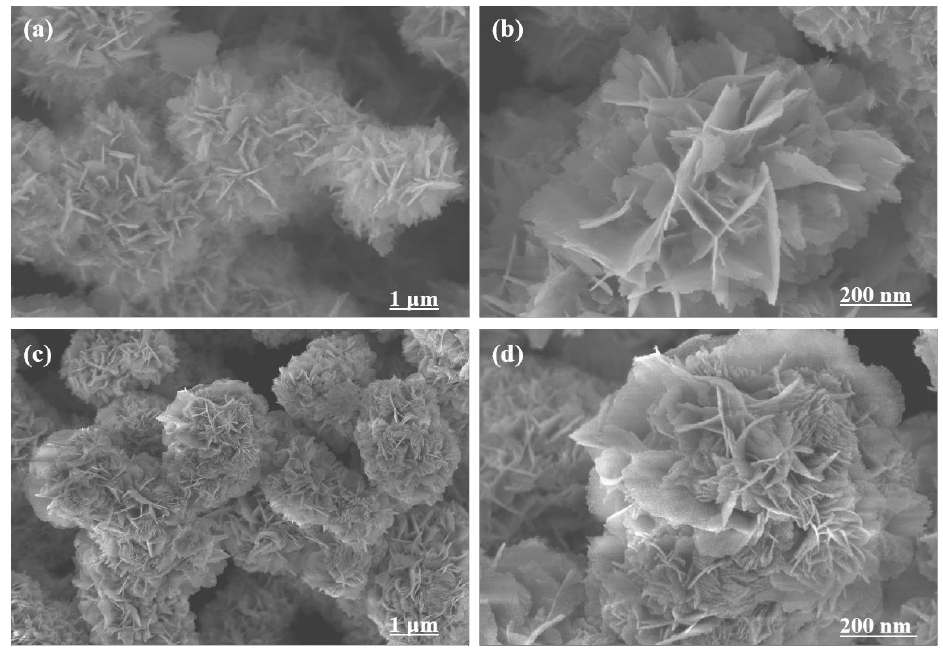
Figure 2. SEM images of ( a, b ) SnS and ( c, d ) CdS/SnS.